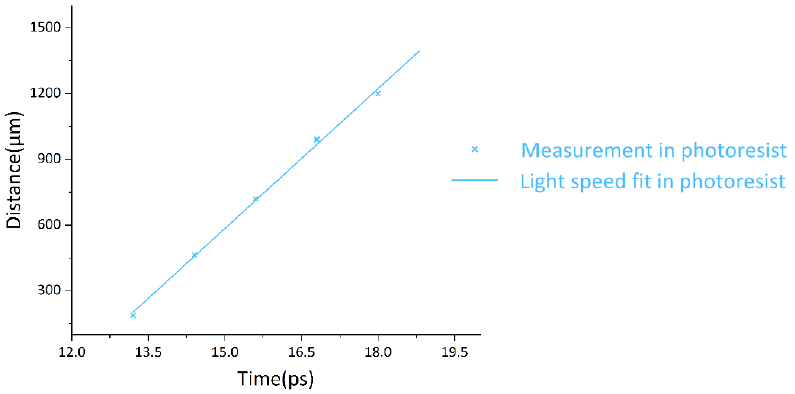
Figure 6. Recovered light speed in photoresist mixture.